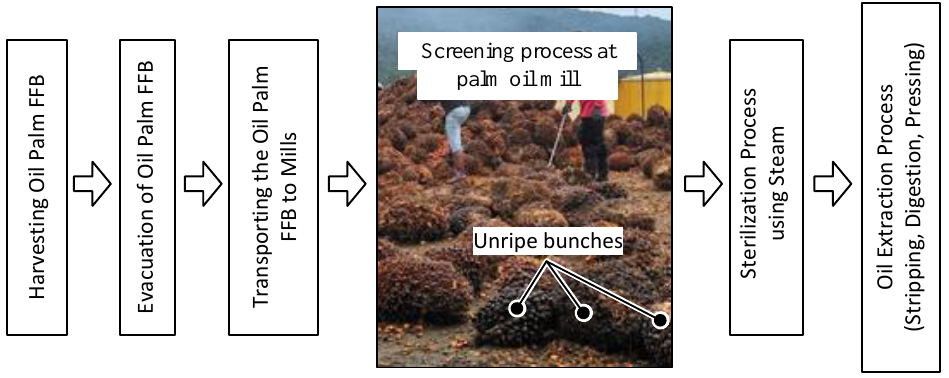
Figure 1. Procedure of oil palm fresh fruit bunches’ (FFB) processing at mills.